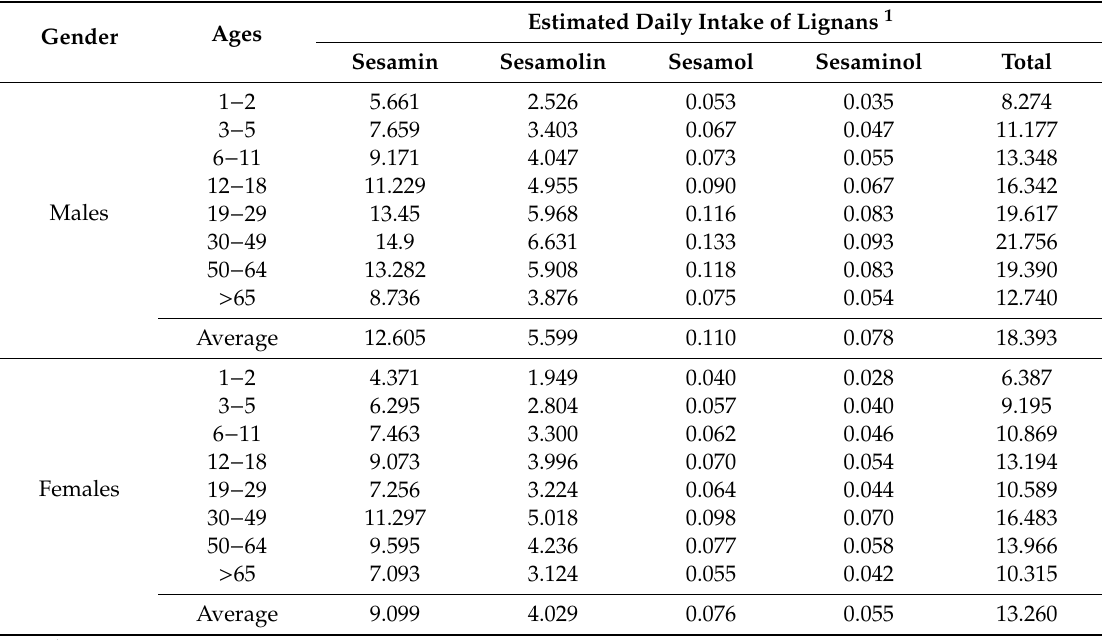
Table 7. Total estimated daily intake (EDI) of lignans from sesame seeds and sesame oil (mg / person / day). Gender